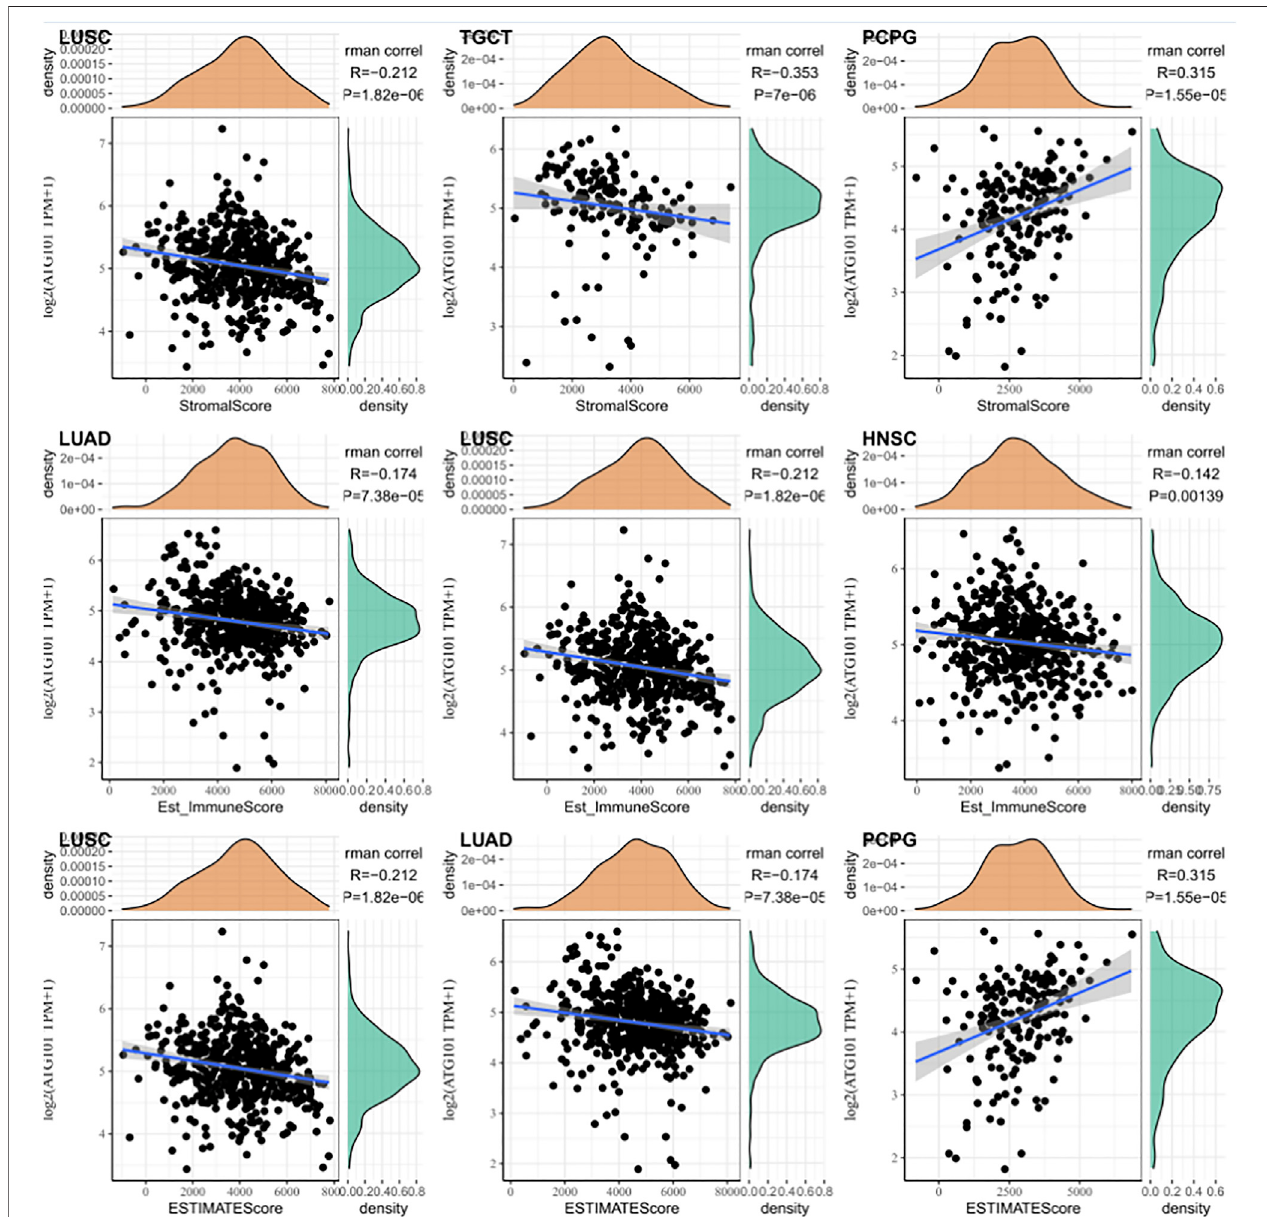
FIGURE 4 | The relationship between the algorithm score in cancer patients and the expression level of ATG101. The third highest correlations with the stromal score, immune score and ESTIMATE score.